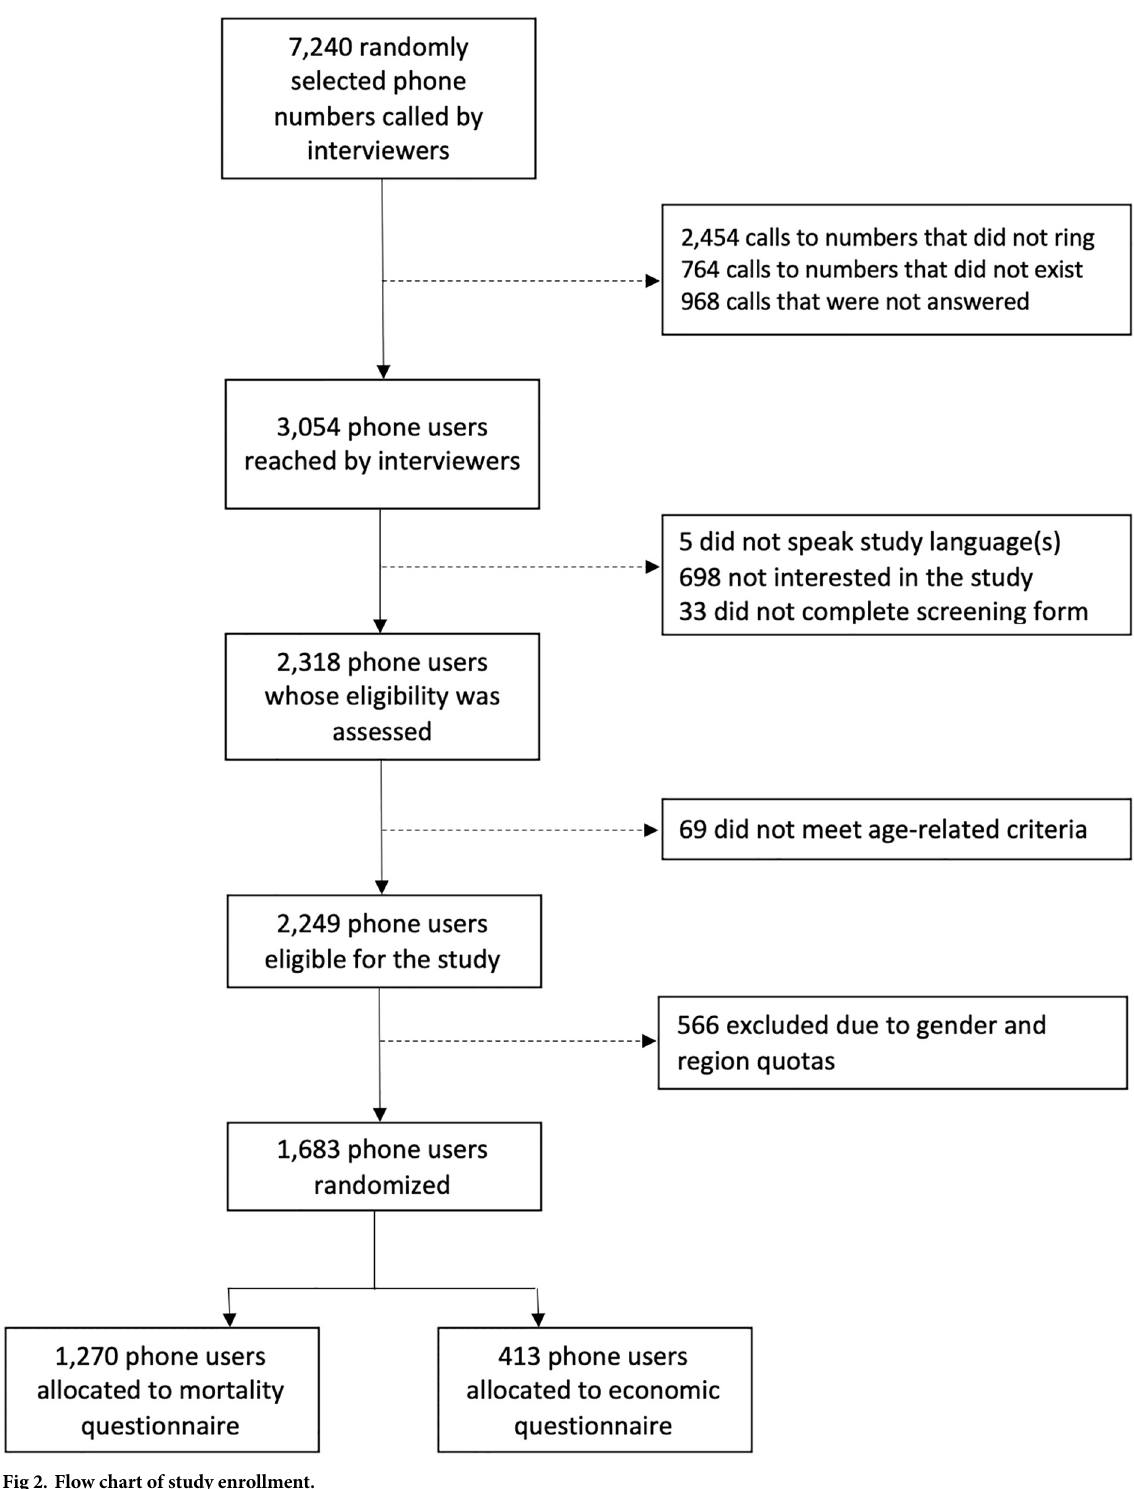
Fig 2. Flow chart of study